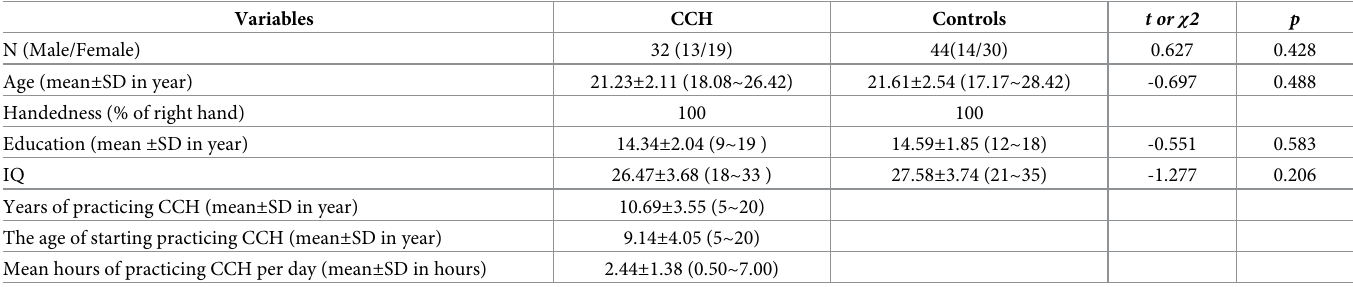
Table 1. Sample characteristics of the CCH and the control